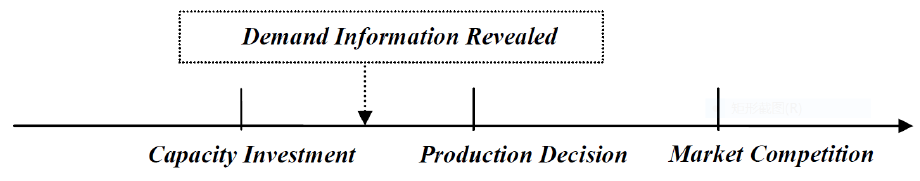
Figure 1. Sequence of Decision